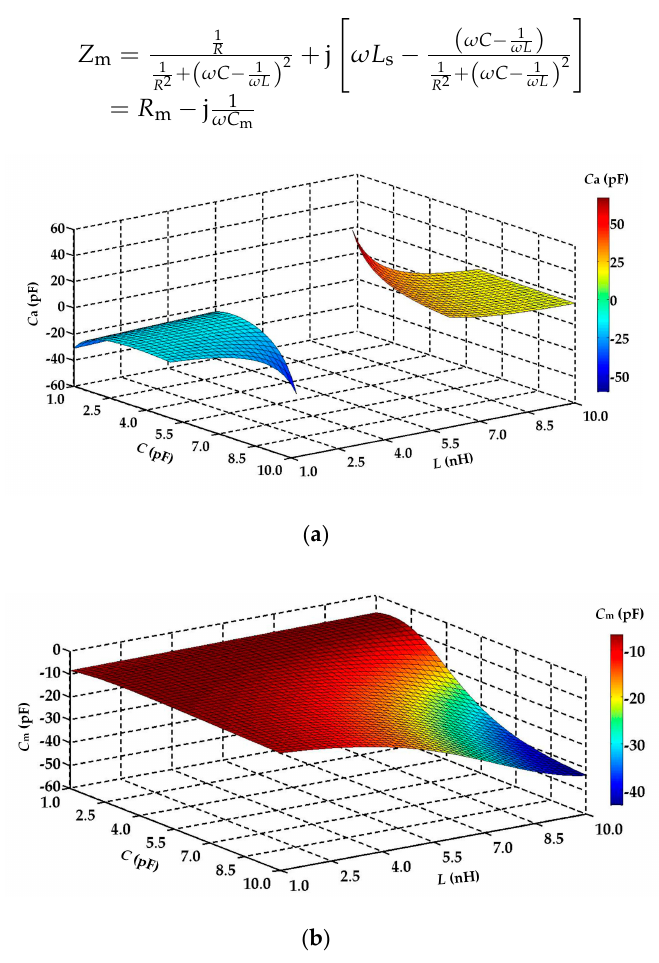
Figure 3. The values of the capacitance: ( a ) C a and ( b ) C m .